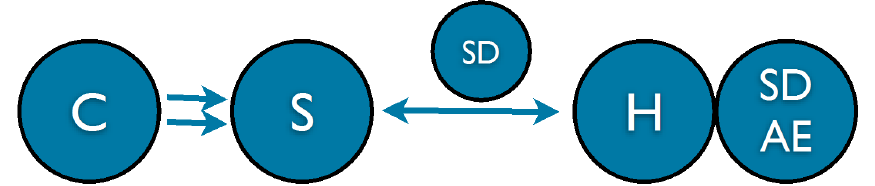
Figure 2. Sensor data augmented experience, SDAE (C = context, S = sensor, SD = sensor data, H =